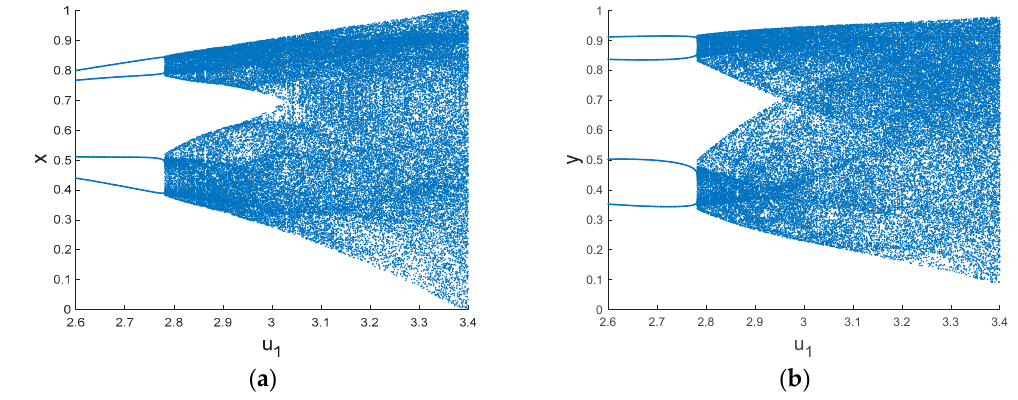
Figure 2. Bifurcation diagram of 2D logistic chaos ( a ) u